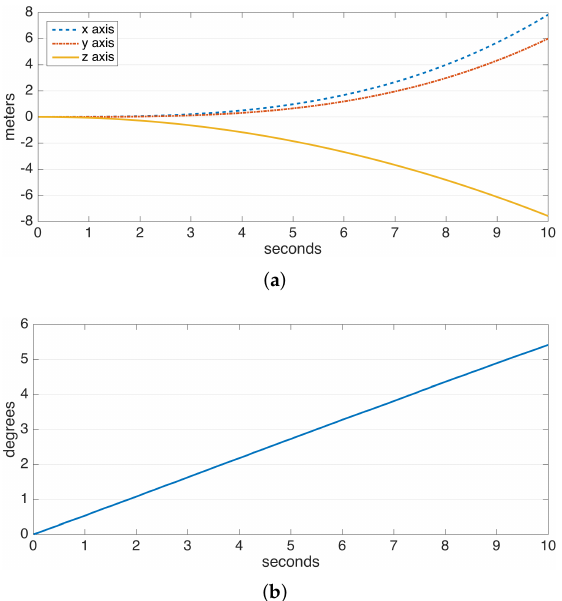
Figure 2. Typical drifts observed in the integration of data from the ( a ) accelerometer and ( b )